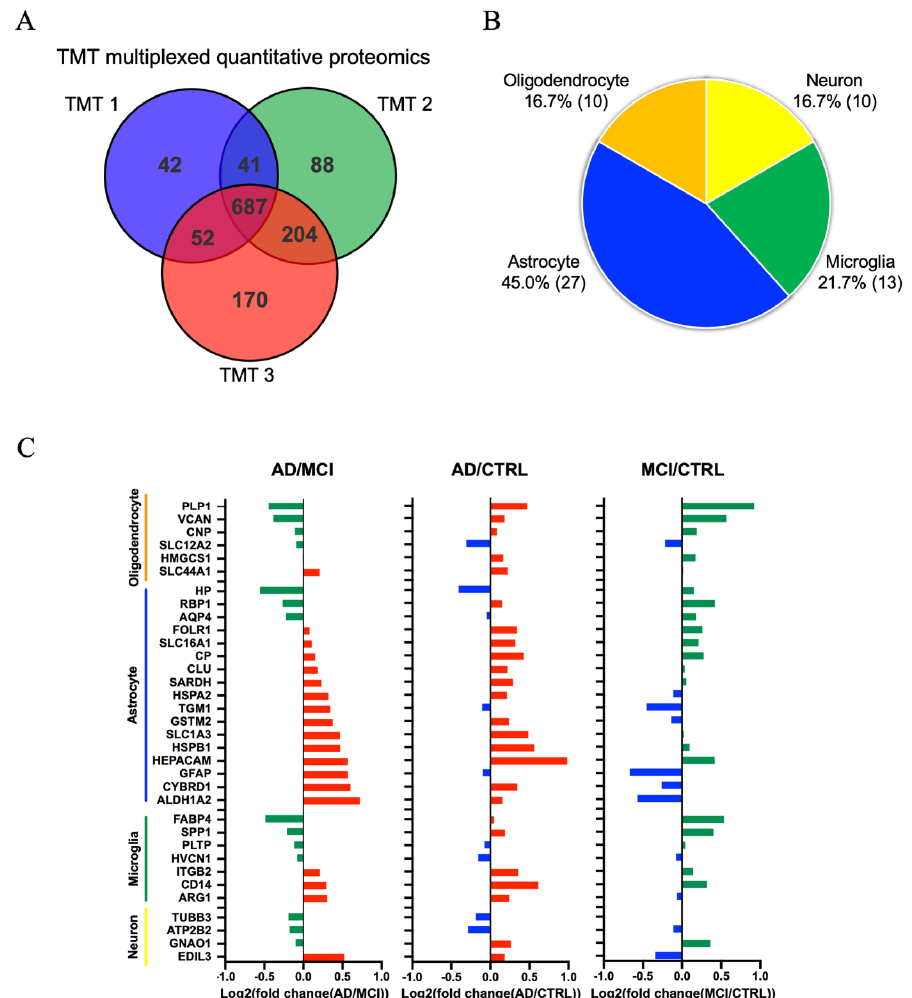
Figure 3. Proteomics comparison of AD, MCI and CTRL CSF-derived EV protein: ( A ) Venn diagram showing the number of proteins reproducibly identified among the three separate TMT-MS. ( B ) Enrichment of brain cell-specific markers in CSF-derived EV proteins and brain-derived EV proteins. Yellow: Neuron, Green: Microglia, Blue: Astrocytes, Orange: Oligodendrocytes. The parentheses show the number of identified cell type-specific proteins. ( C ) Comparison of the cell type-specific proteins in AD CSF-derived EVs, MCI EVs and CTRL EVs. The left panel shows AD vs. MCI. The red bar shows higher expression in AD compared with MCI and the green bar indicates higher expression in MCI compared with AD. The middle panel indicates AD vs. CTRL. The red bar shows higher expression in AD compared with CTRL and the blue bar indicates higher expression in CTRL compared with AD. The right panel shows MCI vs. CTRL. The green bar shows higher expression in MCI compared with CTRL and the blue bar indicates higher expression in CTRL compared with MCI. Table 3. Up- and down- regulated EV proteins in AD or MCI compared to control group. Protein